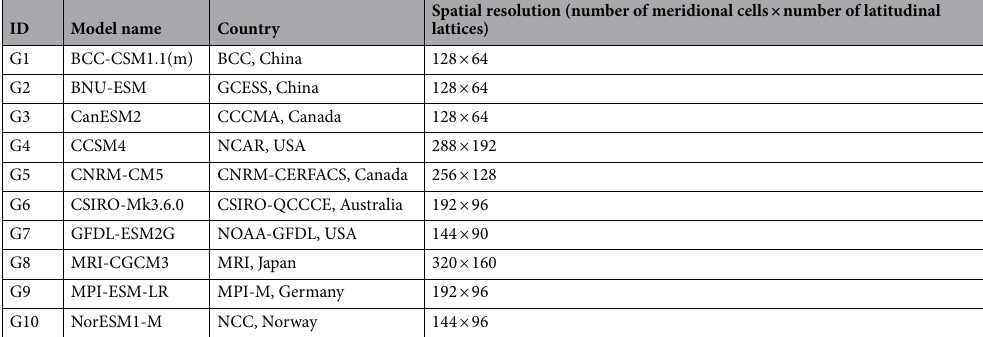
Table 3. The basic information of the selected 10 GCMs.